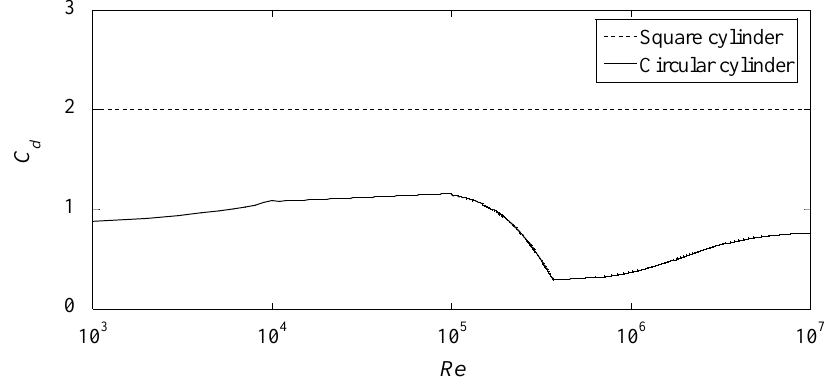
Circular cylinder